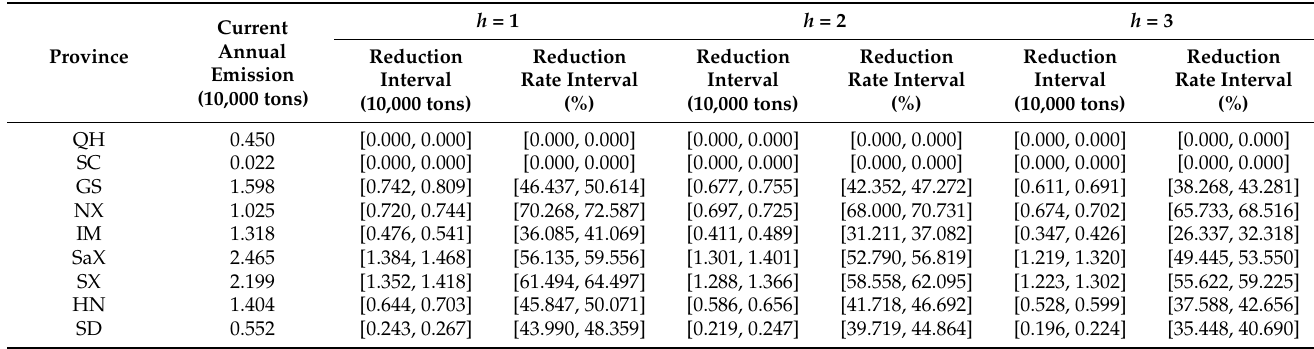
Table 6. The reduction plan of NH 3 -N in each province under different